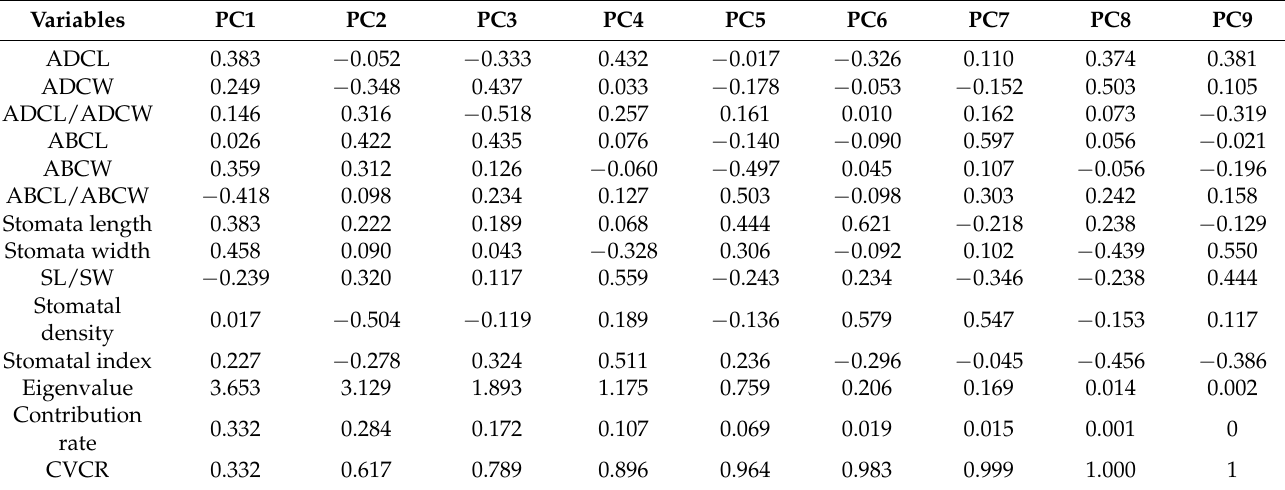
Table 4. Eigen analysis of the correlation matrix.